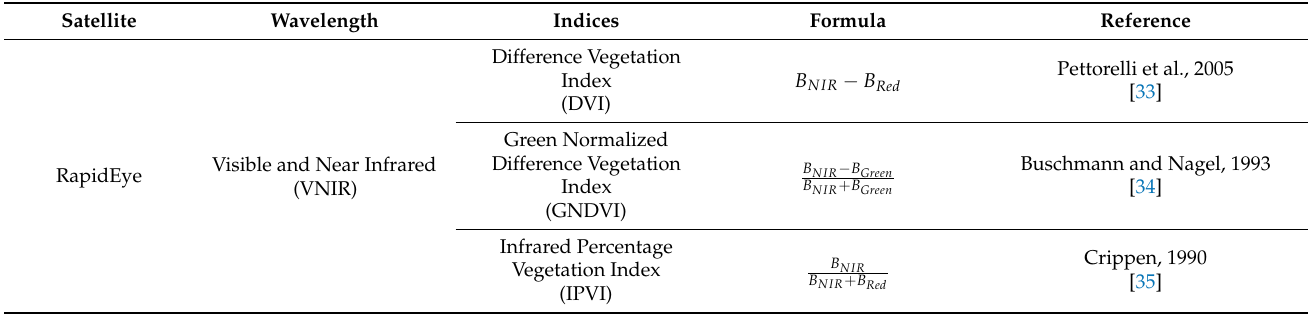
Table 2. Vegetation Indices Derived from RapidEye and